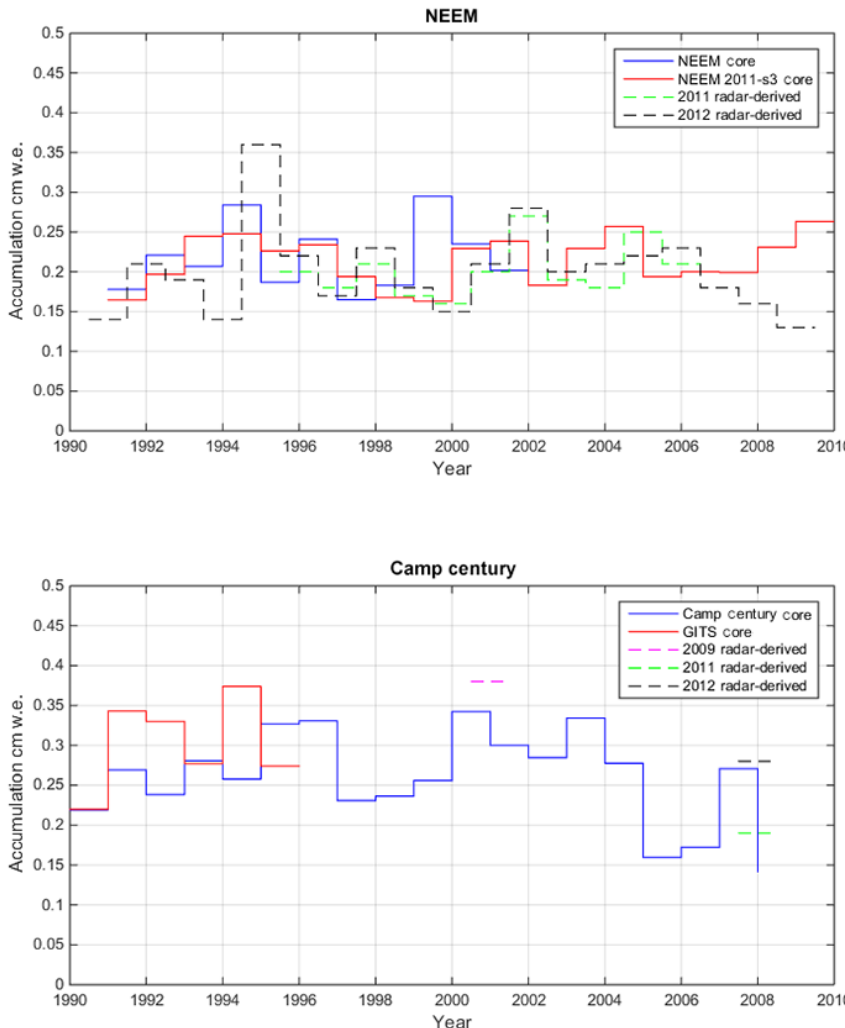
Figure 12. Annual accumulation rate measured from two cores at both the NEEM and Camp Century locations compared to temporally overlapping radar-derived